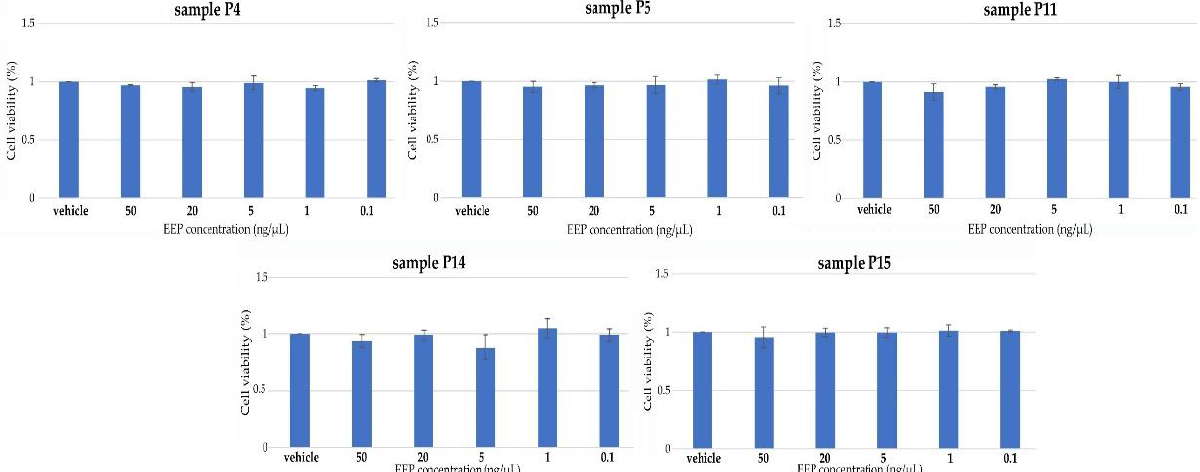
Figure 4. The effect of selected propolis extracts (samples P4, P5, P11, P15, and P15) on HaCaT cell viability. The data are expressed as the mean viability from three independent experiments in each case. (All values in graphs were statistically insignificant).